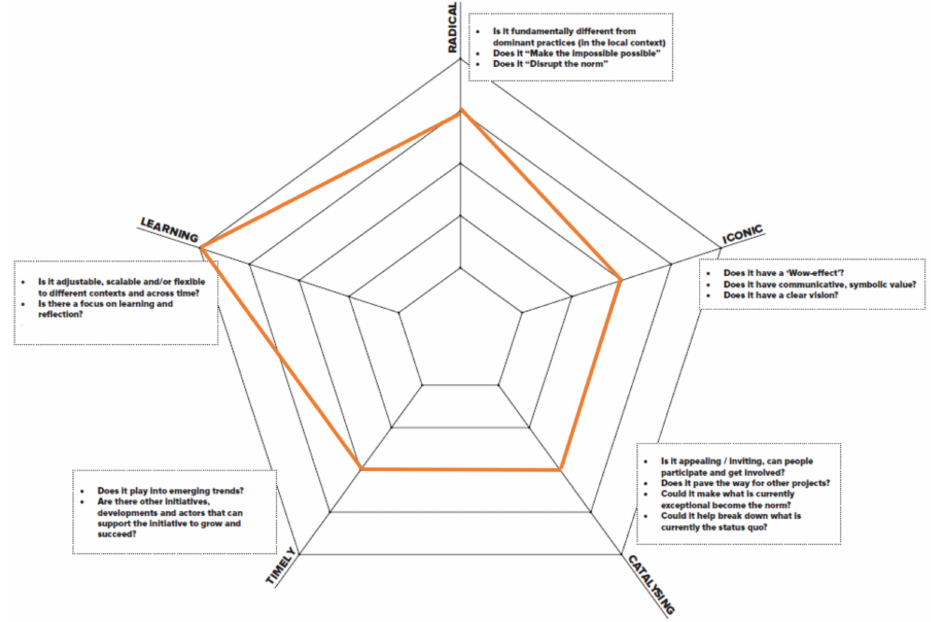
Figure 4. Transformative impact of the citizen science pilot “Air quality measurements in high schools” based on the experience of the pilot